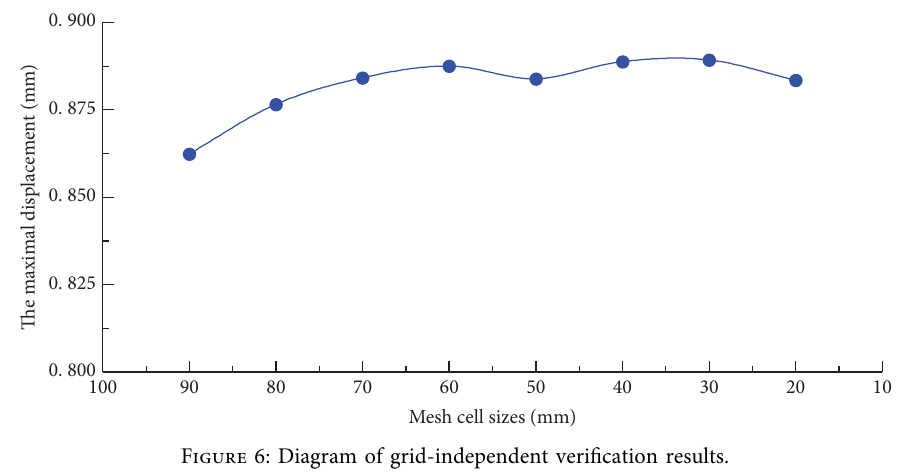
Figure 6: Diagram of grid-independent verifcation results.